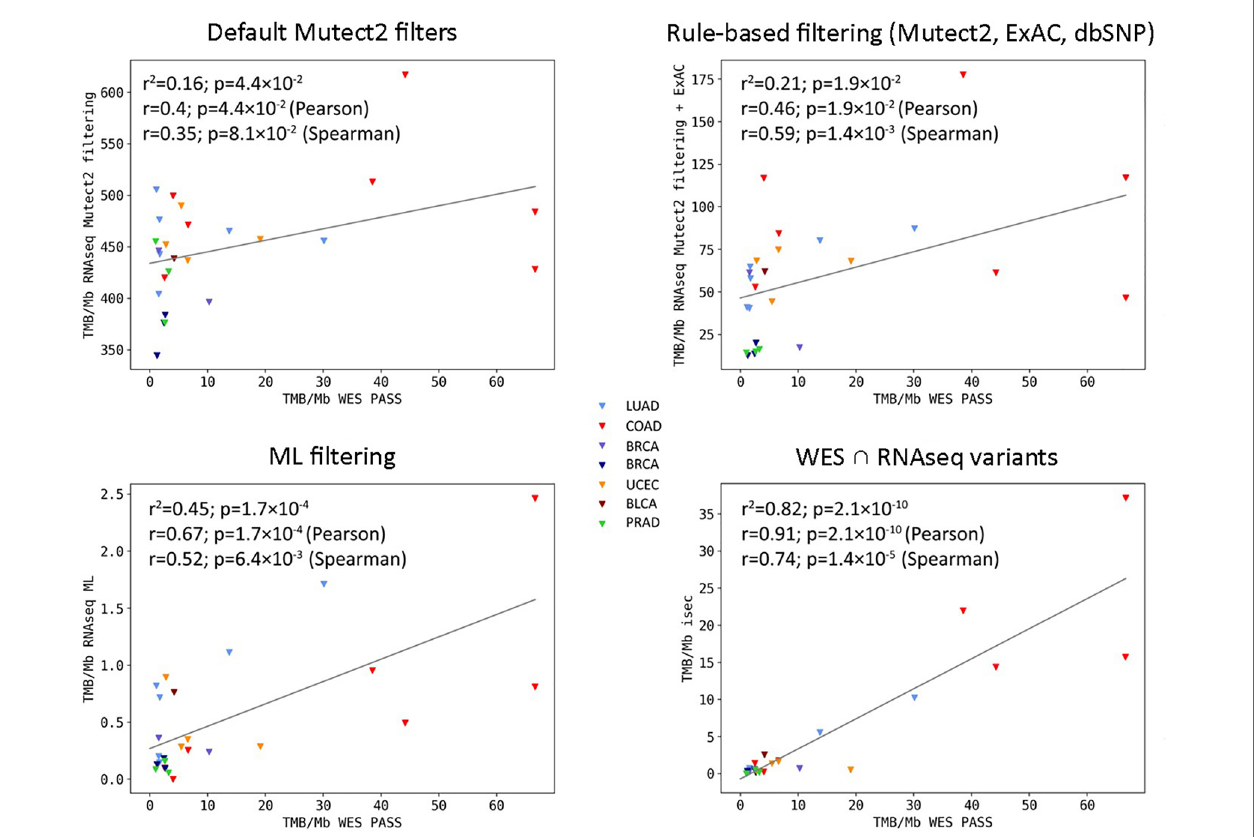
FIGURE 2 | Correlations between RNAseq- and WES-derived tumor mutation burden (TMB) estimates (TCGA FFPE dataset, n = 26), with matched normal WES references. Samples are colored according to cancer type. Cancer type abbreviations used: LUAD, lung adenocarcinoma; COAD, colon adenocarcinoma; BRCA, breast invasive carcinoma; UCEC, uterine corpus endometrial carcinoma; BLCA, urothelial bladder carcinoma; PRAD, prostate adenocarcinoma.